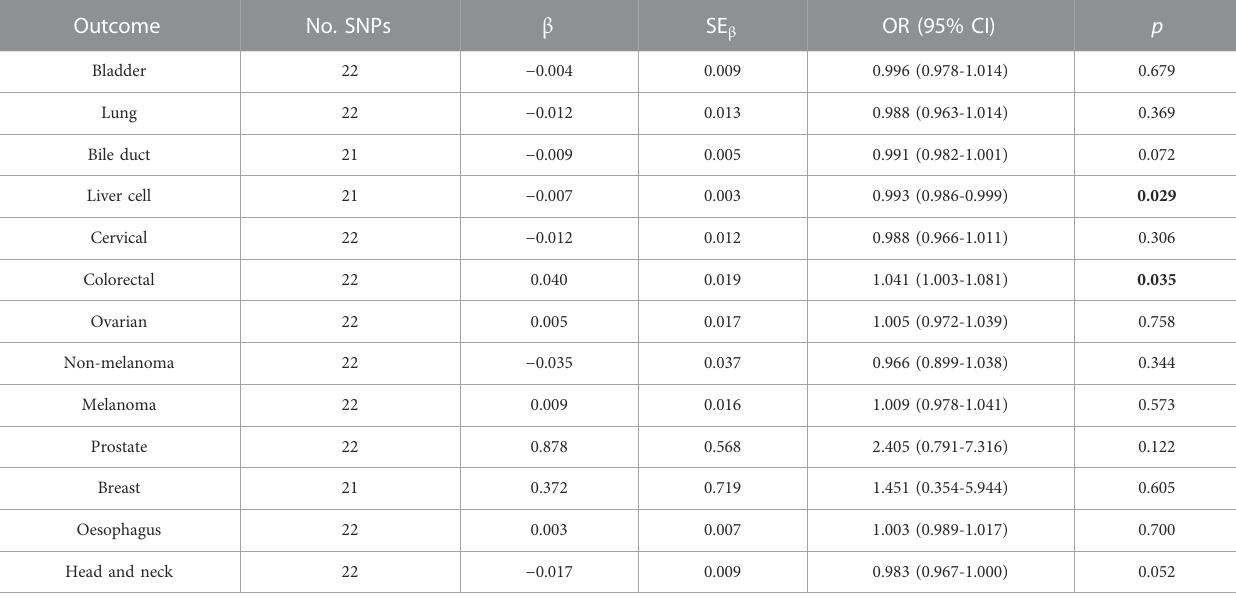
TABLE 2 Two sample MR analysis results of atorvastatin use and pan-cancer via Fixed-effect inverse variance weighted (IVW EF ) method. Outcome No. SNPs